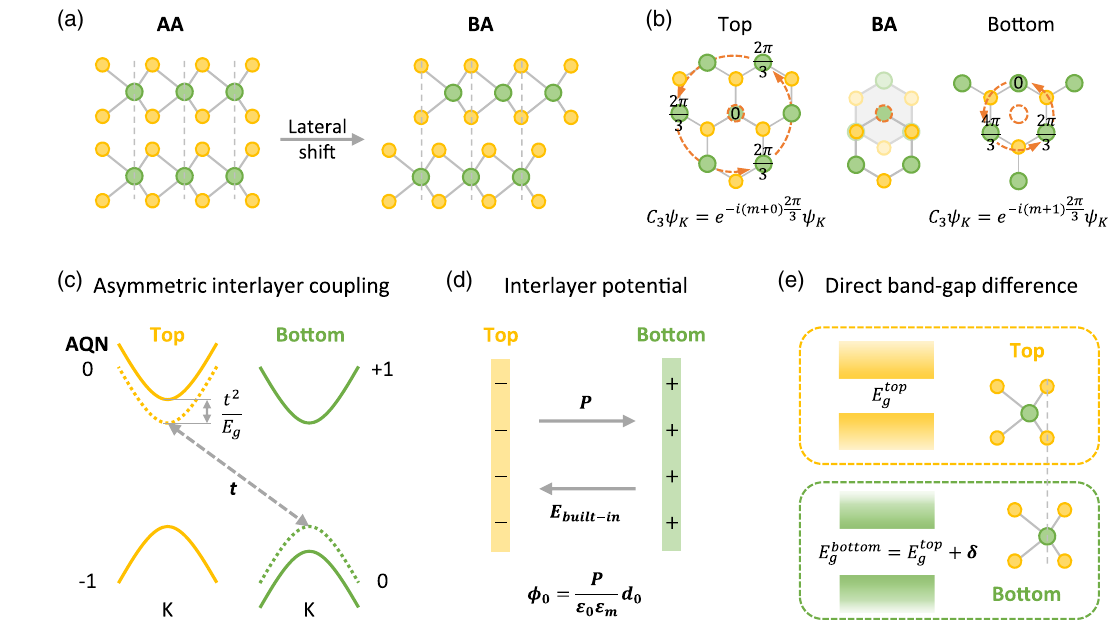
FIG. 1. Schematic of asymmetric interlayer coupling in the 3 R -MoS 2 bilayer. (a) Side view of atomic structures of the 3 R -MoS 2 bilayer with AA (left) and BA (right) stacking configurations, where the yellow and green spheres denote the S and Mo atoms, respectively. (b) Schematic of the phase winding at K points in monolayer MoS 2 when the C 3 rotational center is located at a Mo site (left) and the hollow center of the hexagon formed by Mo and S (right). The middle is the top view of the atomic structure of the 3 R -MoS 2 bilayer with BA stacking configuration. The small, dashed orange circle denotes the C 3 rotational center. (c) Electronic band structure at K points of a 3 R -MoS 2 bilayer with BA stacking configuration. Yellow (green) dashed lines denote the original uncoupled bands. Yellow (green) solid lines denote the bands of the top (bottom) MoS 2 layer. Numbers denote the overall azimuthal quantum number (AQN) of the conduction or valence band edge at K points. Interlayer coupling t exists only between the conduction band of the top layer and the valence band of the bottom layer, resulting in a level repulsion t 2 =E between these two bands, where E is the direct g g band gap of MoS 2 . (d) Schematic of spontaneous out-of-plane polarization P pointing from the top layer (yellow) to the bottom layer (green) in a 3 R -MoS 2 bilayer with BA stacking configuration. (e) Schematic of direct band gap at the K point of the top (yellow) and bottom (green) layer in a 3 R -MoS 2 bilayer with BA stacking configuration. The atomic structure shows the nonequivalent environments of the Mo atom in the top and bottom MoS 2